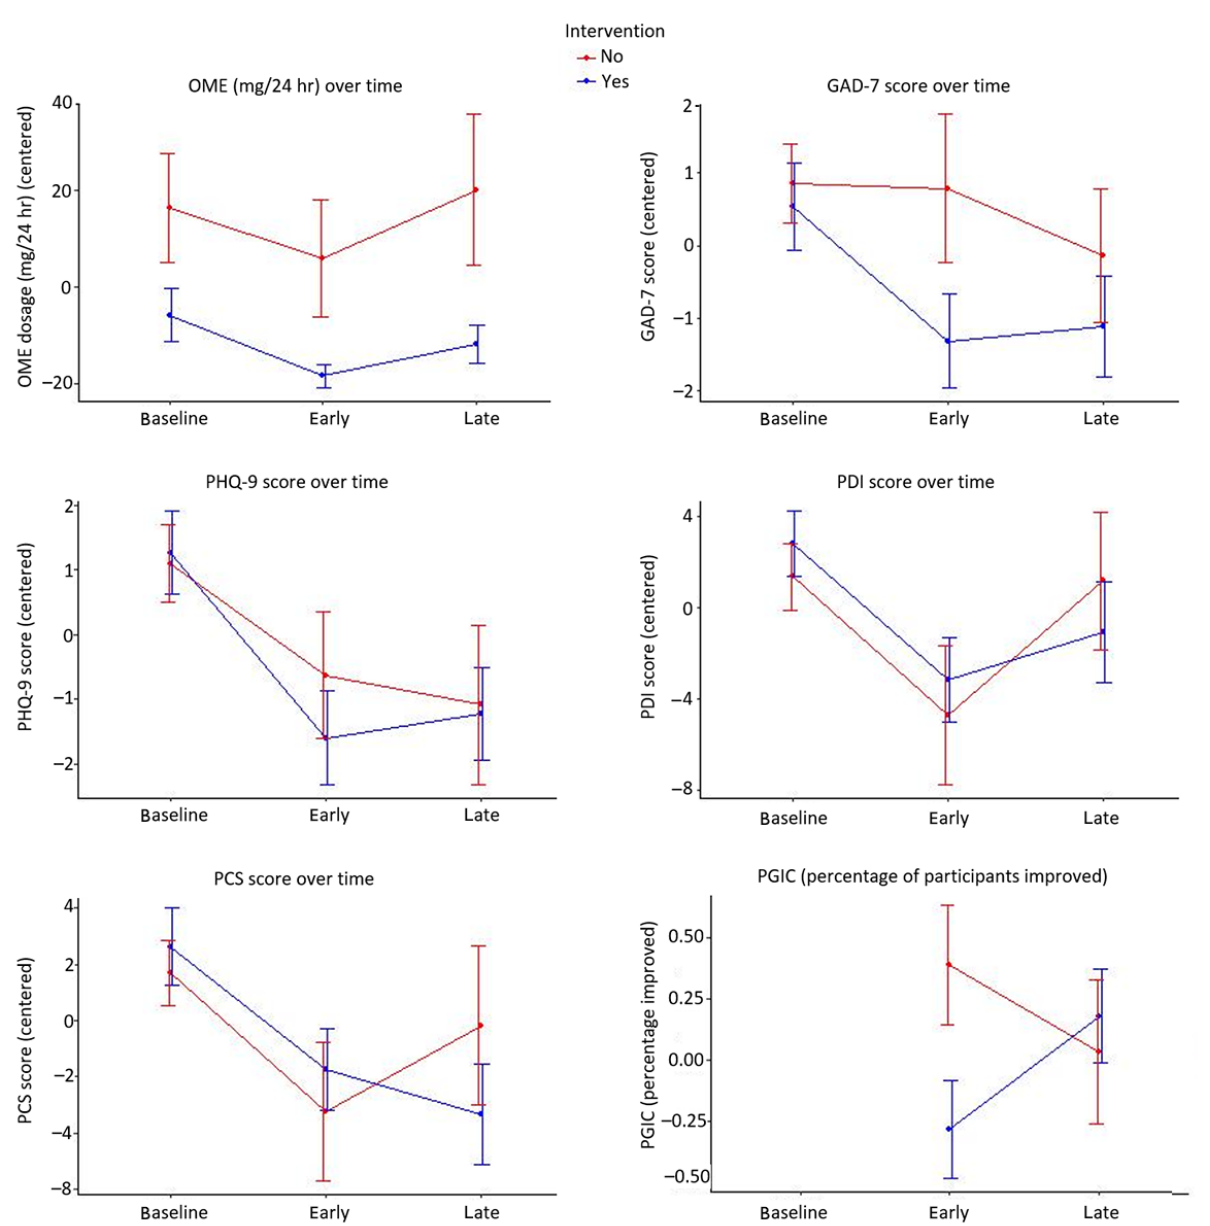
Figure 4. Mean values of validated measures in both app (labelled "Intervention – Yes") and nonapp (labelled "Intervention – No") groups at short-term (early) and long-term (late) follow-ups. Error bars indicate the standard error. Means have been centered along the overall mean. GAD-7: Generalized Anxiety Disorder 7-item scale; OME: oral morphine equivalence; PCS: Pain Catastrophizing Scale; PDI: Pain Disability Index; PGIC: Participant Global Impression of Change; PHQ-9: Patient Health Questionnaire 9-item